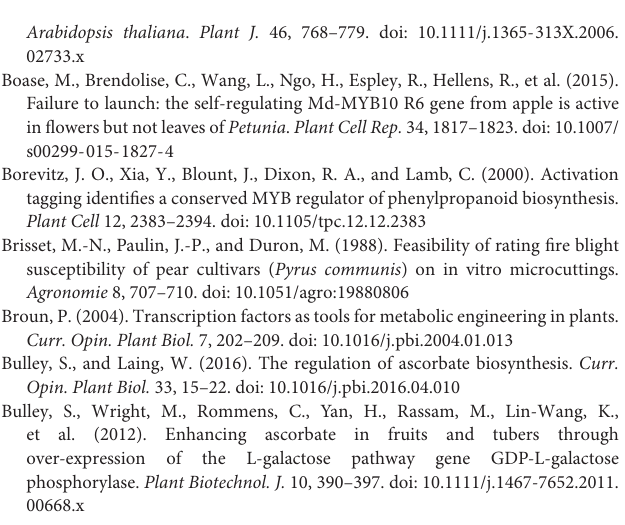
FIGURE S1 | Effect of the insertion of the R6 motif into the AcF3 (cid:48) 5 (cid:48) H promoter. (A) Schematic of the engineered F3 (cid:48) 5 (cid:48) H promoter fused to the LUC reporter gene in pGreen0800LUC. (B) Dual luciferase promoter assay in N. benthamiana . Promoters, with or without the R6 motif, were co-infiltrated with MdMYB10 and MdbHLH3, or AcMYB110 alone. Luminescence of LUC and REN was measured 3 days post-infiltration and expressed as a ratio of LUC to REN. Data represent means ( ± SE) of four technical replicate reactions. (C) Transient expression in N. tabacum of the F3 (cid:48) 5 (cid:48) H gene placed under the control of its own promoter ( F3 (cid:48) 5 (cid:48) H pro :F3 (cid:48) 5 (cid:48) H ), the R6-engineered F3 (cid:48) 5 (cid:48) H promoter ( F3 (cid:48) 5 (cid:48) H-R6 pro :F3 (cid:48) 5 (cid:48) H ) or the 35S promoter ( 35S pro :F3 (cid:48) 5 (cid:48) H ), in presence of AcMYB110. Cyanidin and delphinidin derivatives extracted from tobacco leaves are expressed as concentration of Cy-glu equivalent and (D) presented as a ratio of delphinidin to cyanidin. FIGURE S2 | The number of R1 motifs affect the level of transactivation by MYB110. (A) F3 (cid:48) 5 (cid:48) H promoter, containing 0, 6, 12, or 30 repeats of the R1 motif, fused to the LUC reporter was co-infiltrated with MYB110 in N. benthamiana , and the LUC/REN ratio was calculated as previously. (B) Cyanidin and delphinidin derivatives extracted from tobacco leaves expressing the corresponding engineered promoters driving the F3 (cid:48) 5 (cid:48) H gene were quantified by HPLC and are presented as a ratio of delphinidin to cyanidin (Dp/Cy). FIGURE S3 | ClustalW alignment of the R1 motif from Rosaceous species, Arabidopsis and Actinidia (A) . Box represents required nucleotides for MYB10 binding (Espley et al., 2009). Graphical representation of the conserved residues at each position of the R1 motif was created in WebLogo (Crooks et al., 2004) (B) , the height of each letter representing the relative frequency at that